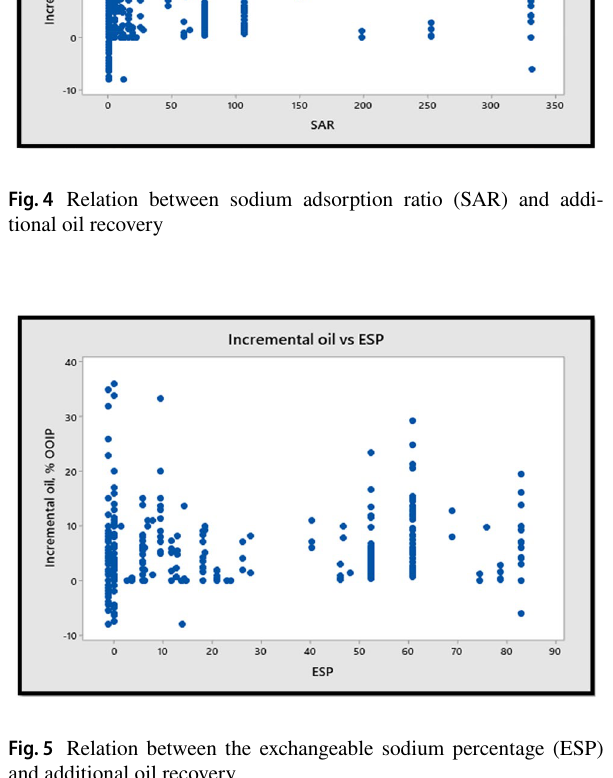
Fig. 5 Relation between the exchangeable sodium percentage (ESP) and additional oil